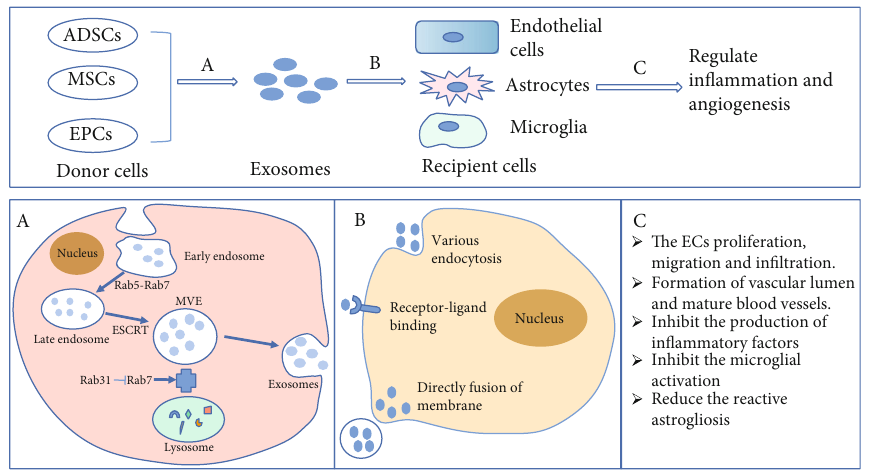
Figure 1: Summary of the exosomal secretion, uptake, and the e ff ect of regulating in fl ammation and angiogenesis. Process A represents the exosomes derived from donor cells such as ADSCs, MSCs, and EPCs. This complex process is relevant to the formation of early endosomes, early endosomes mature into late endosomes, and MVEs fuse with the cell membrane and secrete exosomes. Process B is exosomes that bind to the central nervous system cells such as microglia, astrocytes, and endothelial cells through speci fi c molecular interactions, the direct fusion of membrane, and various endocytosis. Process C shows the e ff ect of exosomes in regulating in fl ammation and angiogenesis by promoting the formation of the blood vessel and suppressing the production of neuroin fl ammatory mediators following stroke. Abbreviations: ADSCs: adipose-derived stem cells; MSCs: mesenchymal stem cells; EPCs: endothelial progenitor cells; MVEs: multivesicular endosomes; ESCRT: endosomal-sorting complex required for